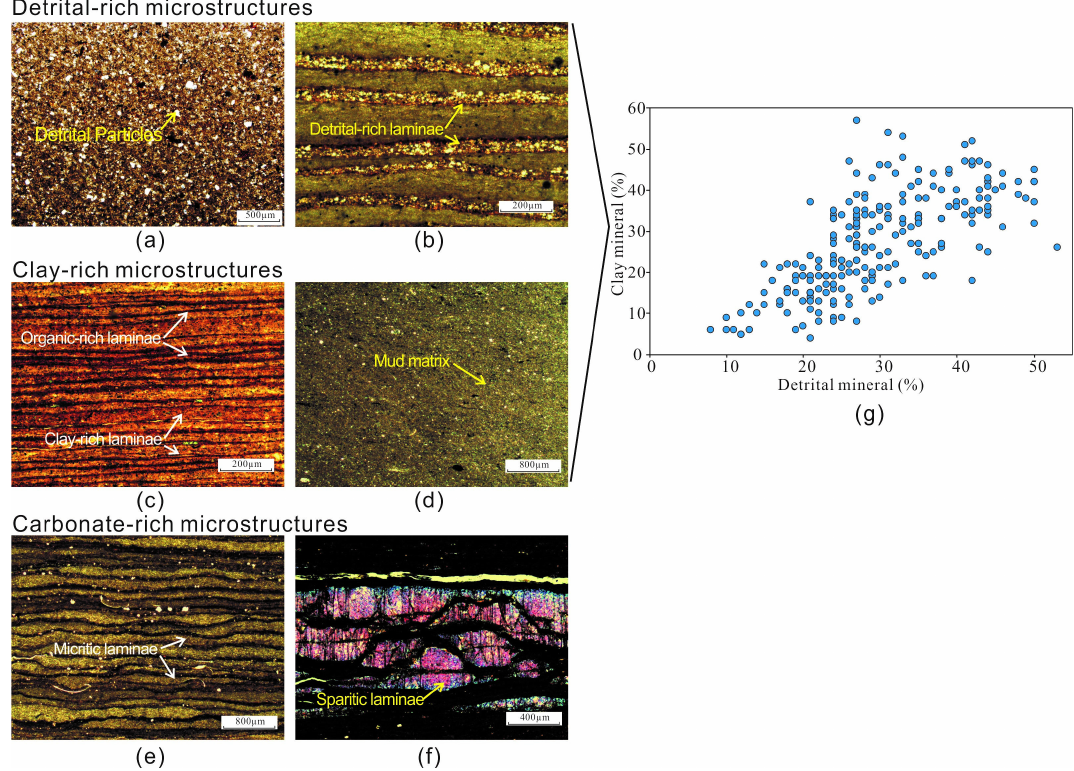
Figure 6. Photomicrographs of various microstructures dominated by different minerals and the relationship between detrital and clay minerals. ( a ) Detrital grains scattered randomly throughout the matrix. ( b ) Detrital particles preserved in rock as silt laminae. Both ( a ) and ( b ) are silt-rich microstructures. ( c ) Couplets of light clay-rich laminae and organic-rich laminae, where the main minerals of both laminae are clay minerals. ( d ) Homogeneous mud matrix. Carbonate-rich microstructures including ( e ) Micritic laminae and ( f ) Veins of sparite. ( g ) Cross plot of detrital mineral content and clay mineral content.